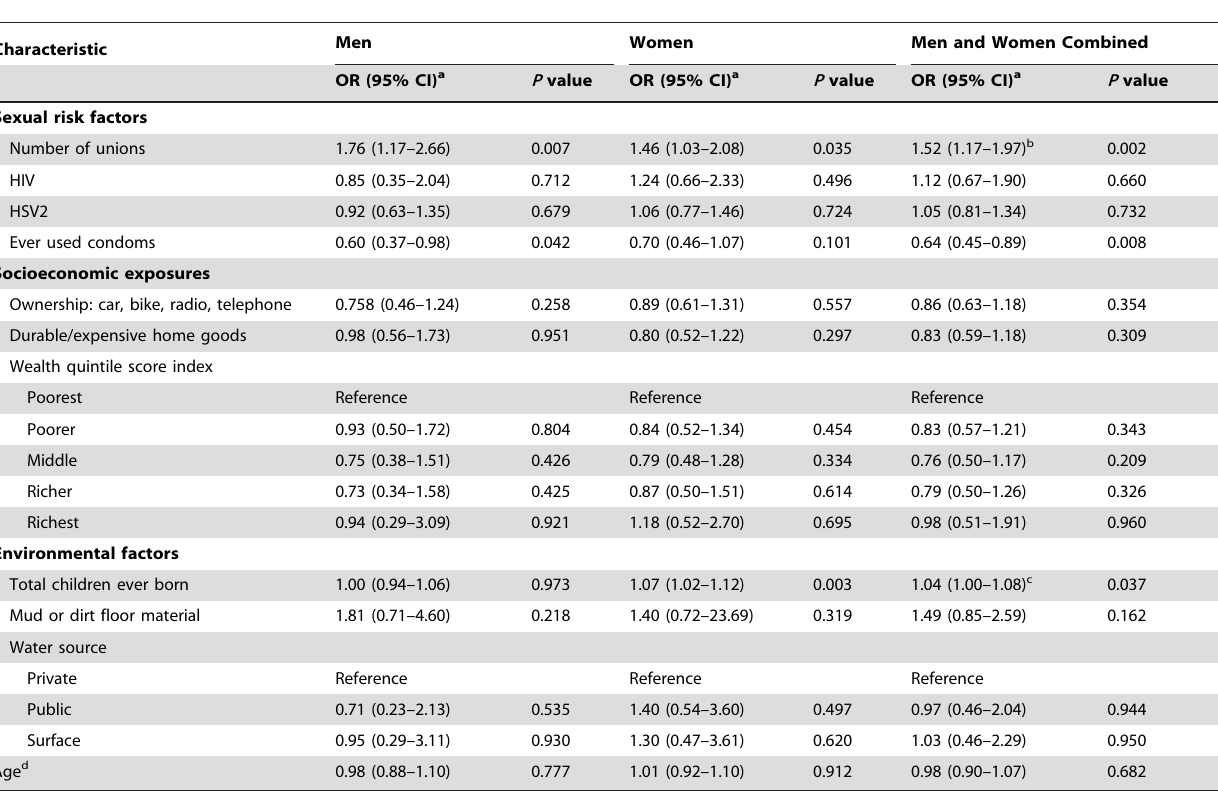
Table 3. Adjusted association between HHV8 seropositivity and selected risk factors among sexually active adults in Uganda.